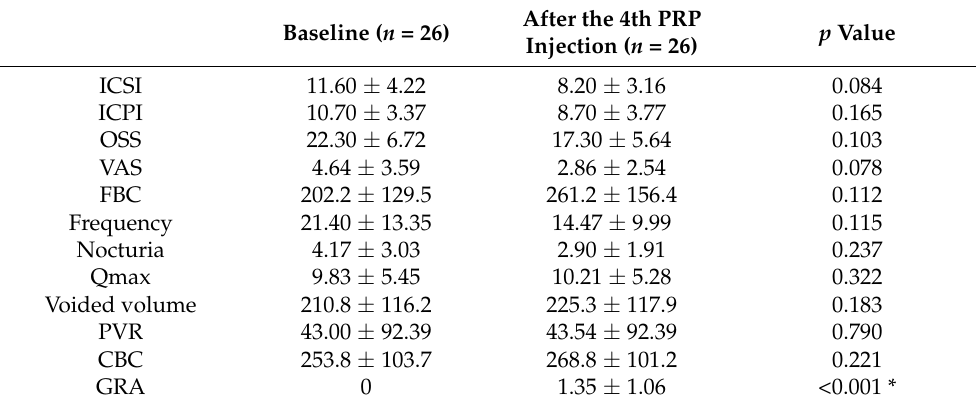
Table 1. Changes in clinical symptom scores and video urodynamic study parameters from baseline to after the platelet-rich plasma injections.